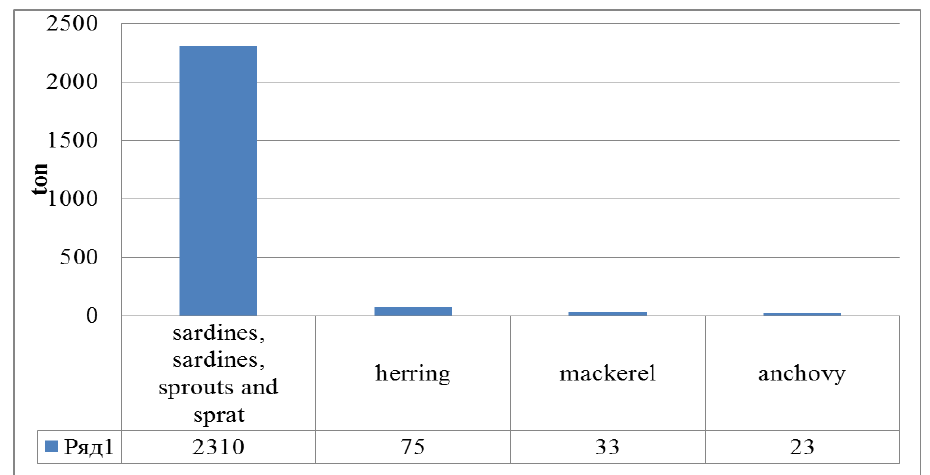
Fig. 6. The export of processed or canned fish products of Ukraine in 2019, tons